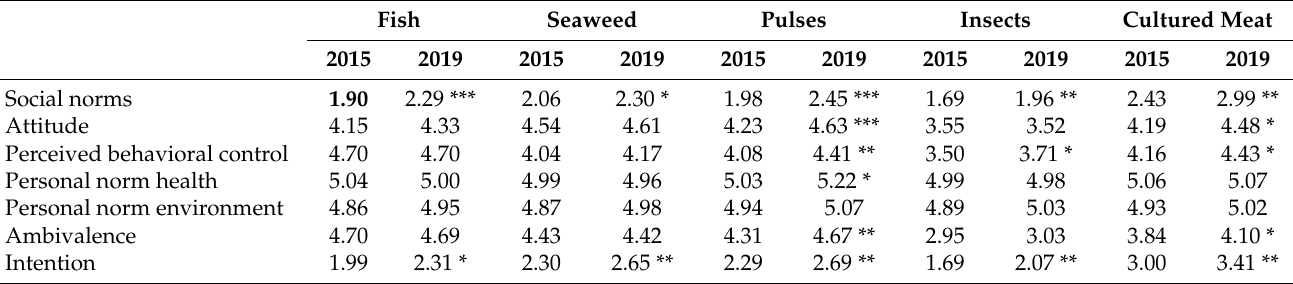
Table 2. Differences in the mean scores across alternative proteins and years for intentions and its drivers. Fish Seaweed Pulses Insects Cultured